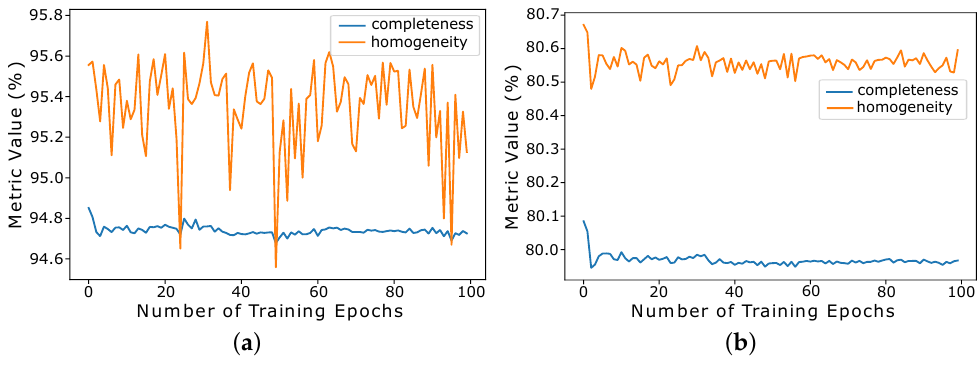
Figure 8. Performance evaluation of ELINAC for the completeness and homogeneity metrics. ( a ) spe- cific clusters and ( b ) generalist clusters.